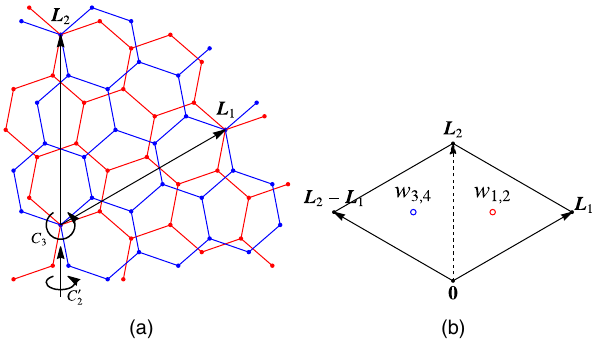
FIG. 1. (a) The superlattice of twisted bilayer graphene. Blue (red) sites are the carbon atoms on the bottom (top) layers. The triangular lattice forms when twisted angle is commensurate. The plot shows the lattice when m ¼ 2 and n ¼ 1 . (b) The center of the local Wannier states. Black dots are the sites of the triangular superlattice. Red and blue dots are two nonequivalent Wyckoff sites, where the local Wannier states are centered. In our construction, w 1 and w 2 are placed at one Wyckoff position, and w 3 and w 4 are placed at another position. Note that the Wychoff sites form an emergent honeycomb lattice.